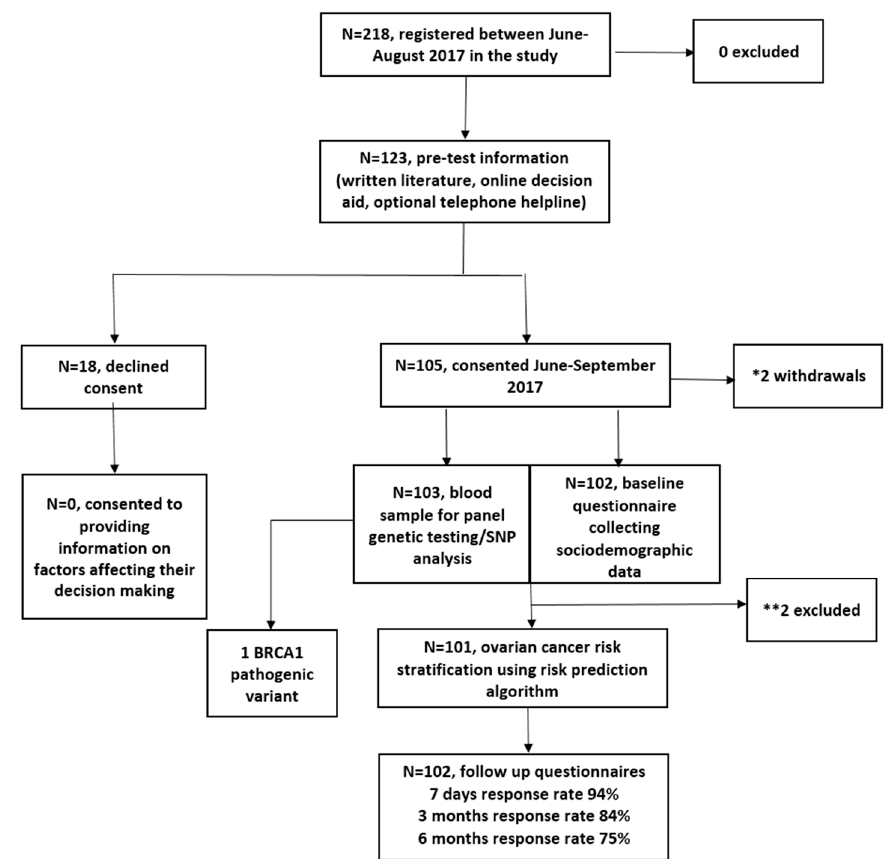
Figure 1. Study flow chart. * Reasons for withdrawal: miscarriage ( n = 1) and inability to use public transport to attend an outpatient blood test appointment for genetic testing ( n = 1). ** Reasons for exclusion: one participant was excluded because she entered this study at age 84 and the model predicts risks to age 80; the second participant did not provide the baseline demographic information required to run the algorithm.